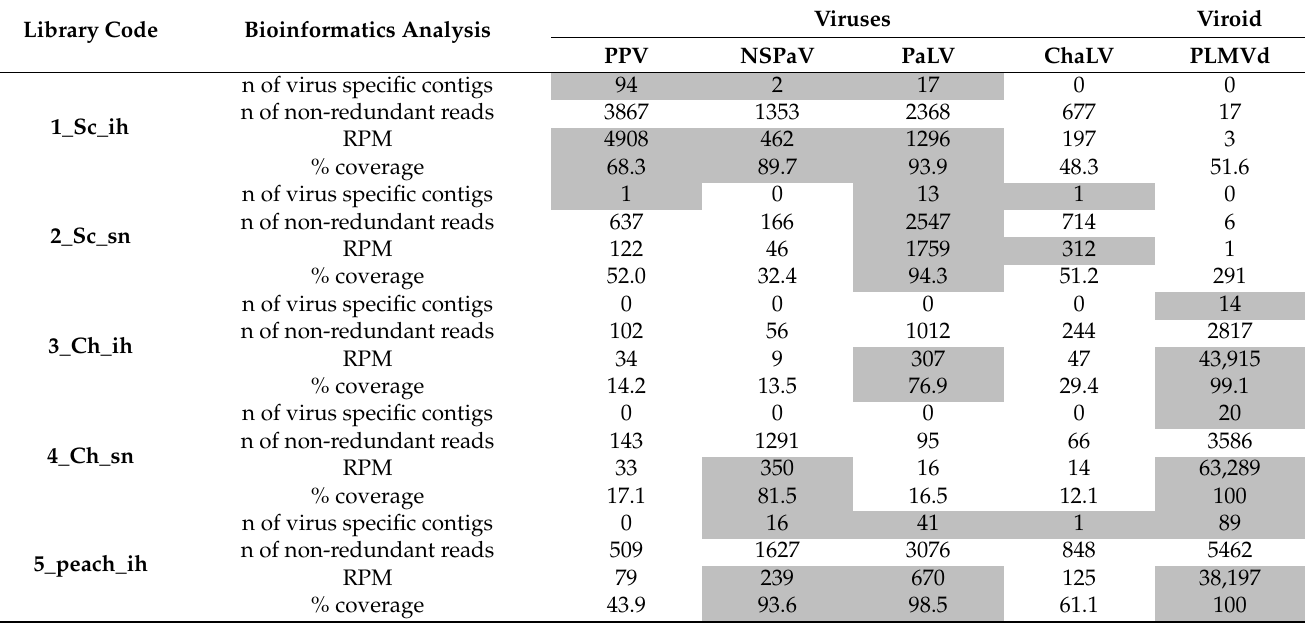
Table 2. Summary of the bioinformatics analysis. Library codes are the same as those detailed in Table 1 (Sc: Springcrest; Ch: Cresthaven; ih: isolator house; sn: stock